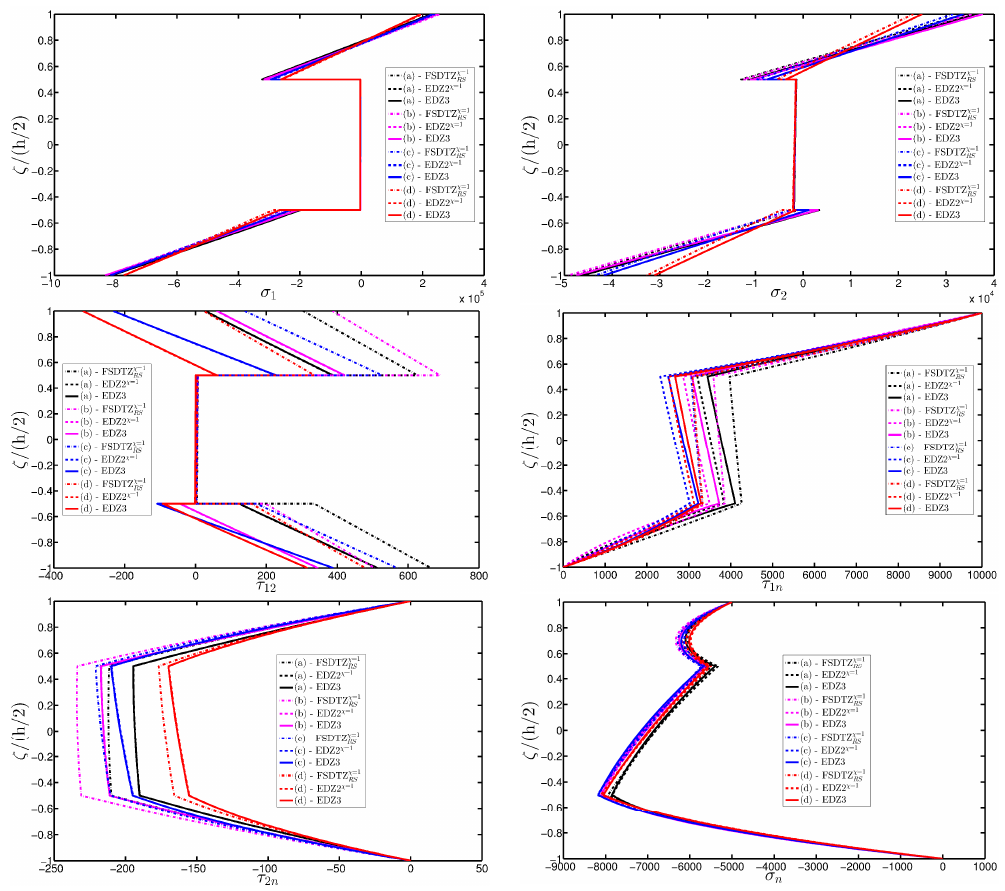
Figure 22. Through-the-thickness profiles of stress components [Pa] for the FCFC soft-core cylindrical surface computed at the point B for different HSDTs. The effect of the damage is investigated by varying the parameters of the function Ell-1.